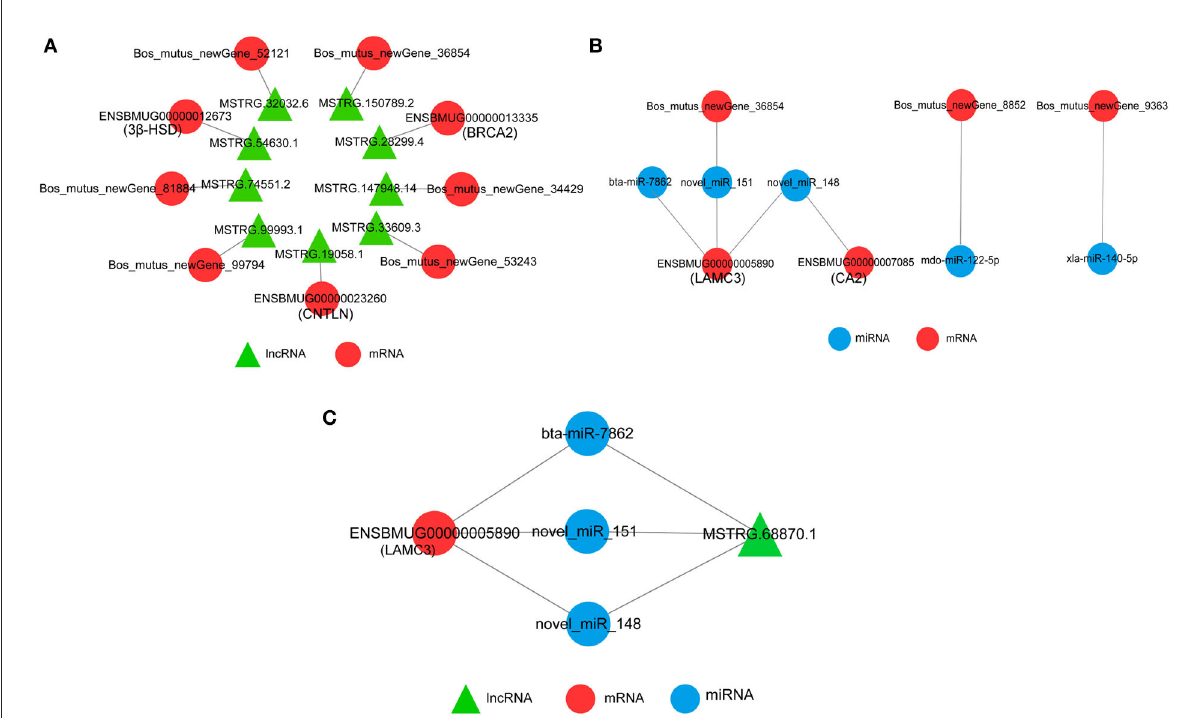
FIGURE8 Interaction network of DEmRNAs, DElncRNAs, and DEmiRNAs. (A) Interaction of DEmRNAs and DElncRNAs. (B) Interaction of DEmRNAs and DEmiRNAs. (C) CeRNA network of DEmRNAs, DElncRNAs, and DEmiRNAs.